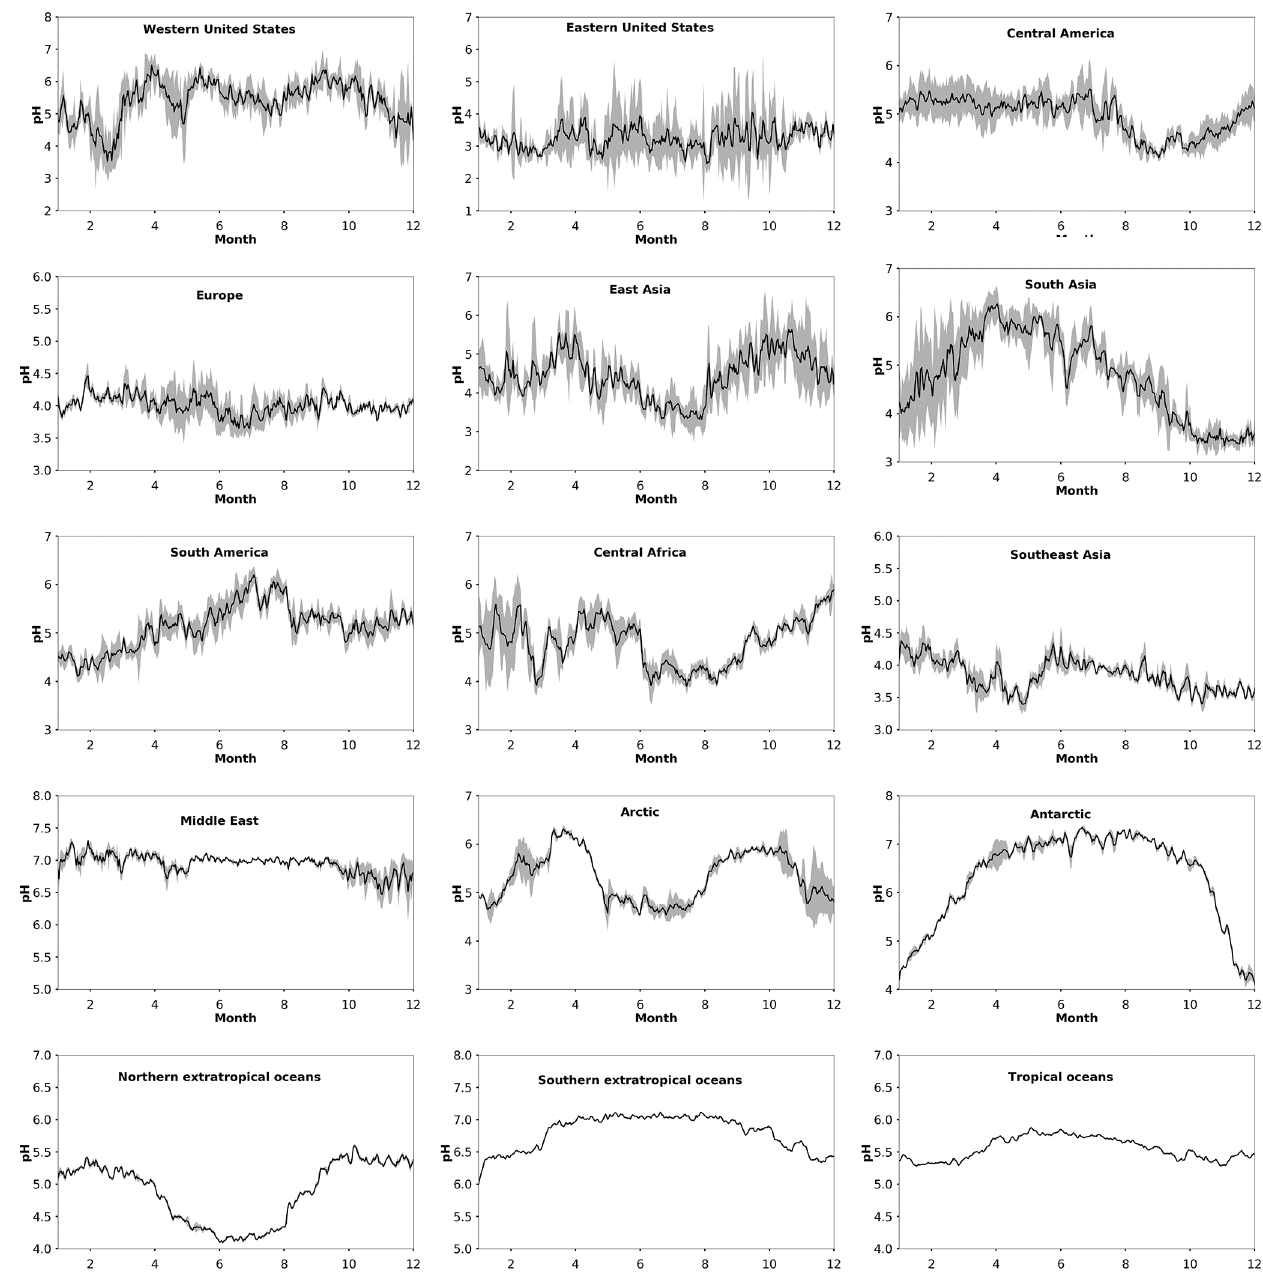
Figure 2. Average seasonal cycle of modeled pH during the period 2010–2015 at locations defined in Table 1. Ranges represent the 1 σ